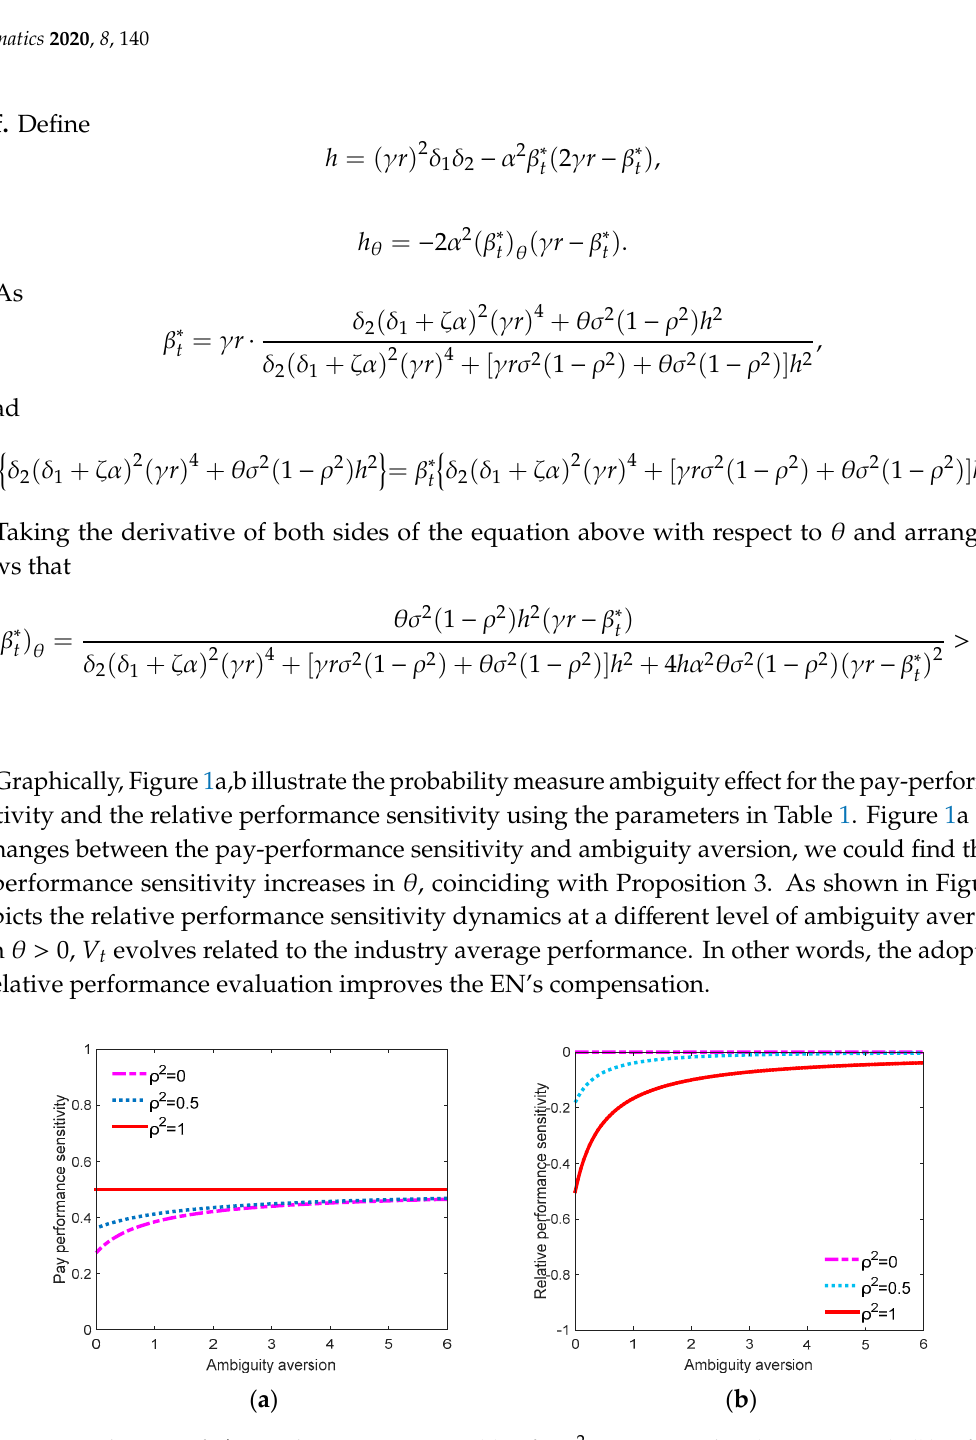
Figure 1. Changes of β ∗ in ambiguity aversion: ( a ) θ for ρ 2 = 0, 0.5 and 1. (Note: α = 1 ); ( b ) θ for t ρ 2 = 0, 0.5 and 1. (Note: α =